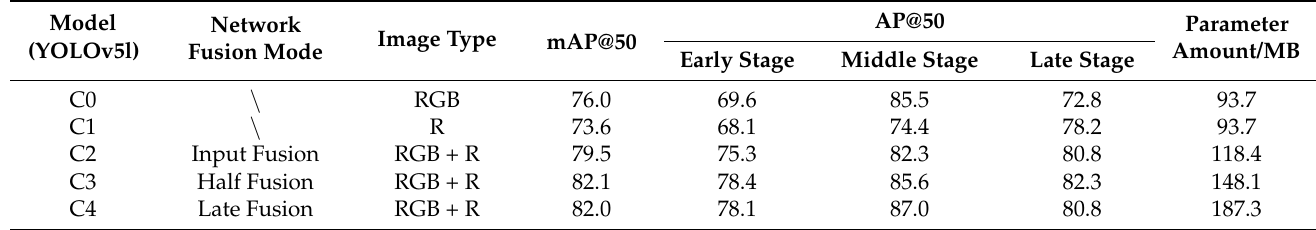
Table 5. Detection performance of different network fusion modes on CP dataset.